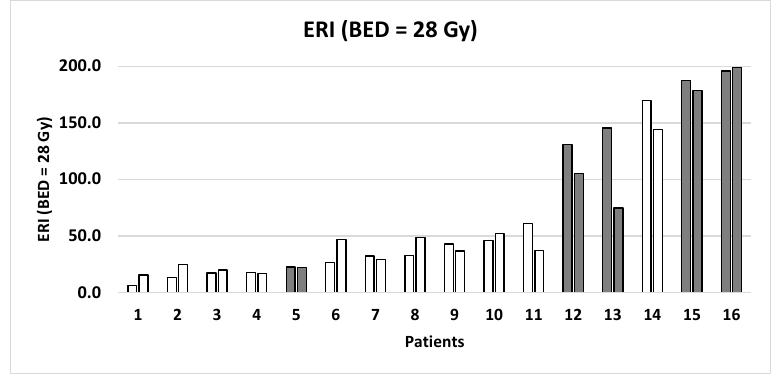
Figure 3. ERI TCP values calculated at the most significant BED level for both observers (one column the highest predictive performance (BED = 28 Gy), no significant difference was observed using the DeLong’s test (all p -values were >0.05).